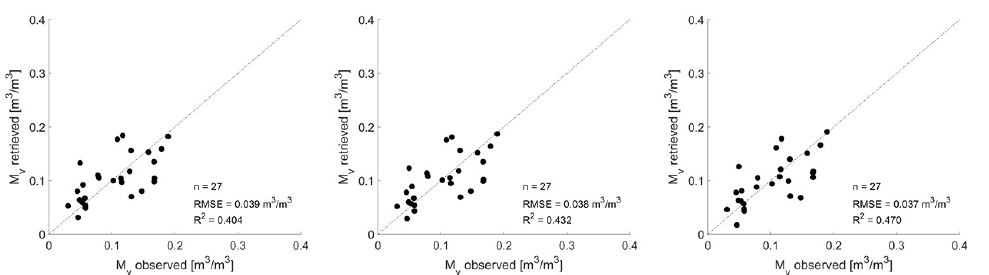
Figure 12. Simulated field-average soil moisture values based on effective roughness modeling for the AIEM against observed field-average soil moisture values. Left : using HH- and VV-polarized backscatter data of the BELSAR campaign. Middle : using HH- and VV-polarized backscatter and XTI bistatic scattering data of the BELSAR campaign. Right : using HH- and VV-polarized backscatter and ATI bistatic scattering data of the BELSAR